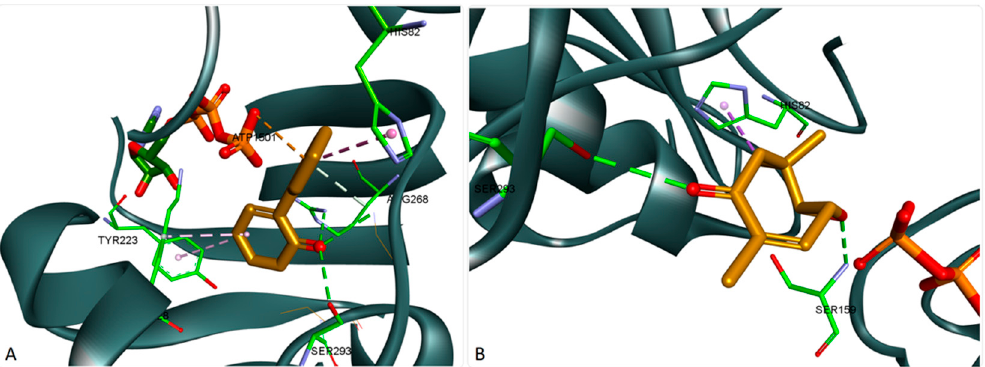
Figure 3. Structure of DDl (2ZDQ) in complex with lavamenthe ( A ) and 3,6,6-Trimethyl-8-oxabicyclo [5.1.0] oct-2-en-4-one ( B ); hydrogen bond interactions are depicted as green dotted lines, hydrophobic interactions as purple dotted lines, and electrostatic interactions in orange; interacting aminoacids are shown as green sticks.